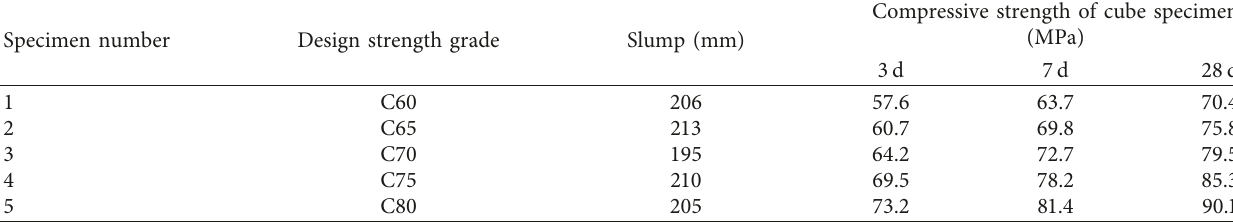
Table 3: HSHPC strength test